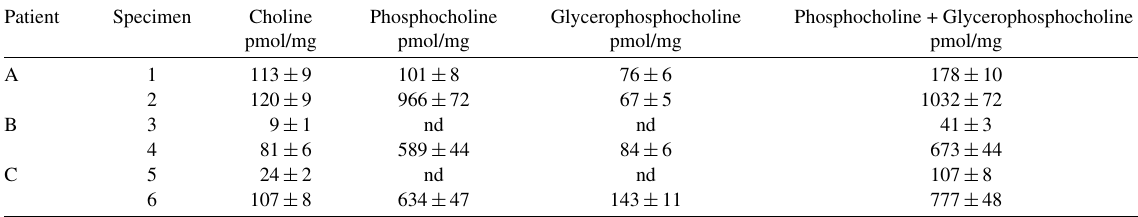
Resultsof1DNMRestimateofChoanditsphosphorylatedderivativesconcentrations.Theerrorswerederivedfromequation(4)(Supplementary Material Section). For specimens 3 and 5 the deconvolution of PCho and GPCho peaks was not possible, therefore only the total concentration estimate is